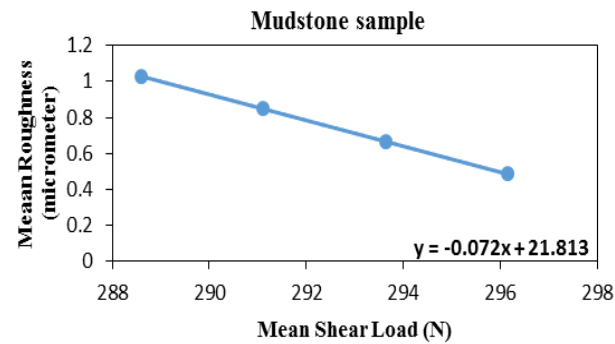
Figure 26. The average surface roughness versus the mean tangential force at four different DOCs in